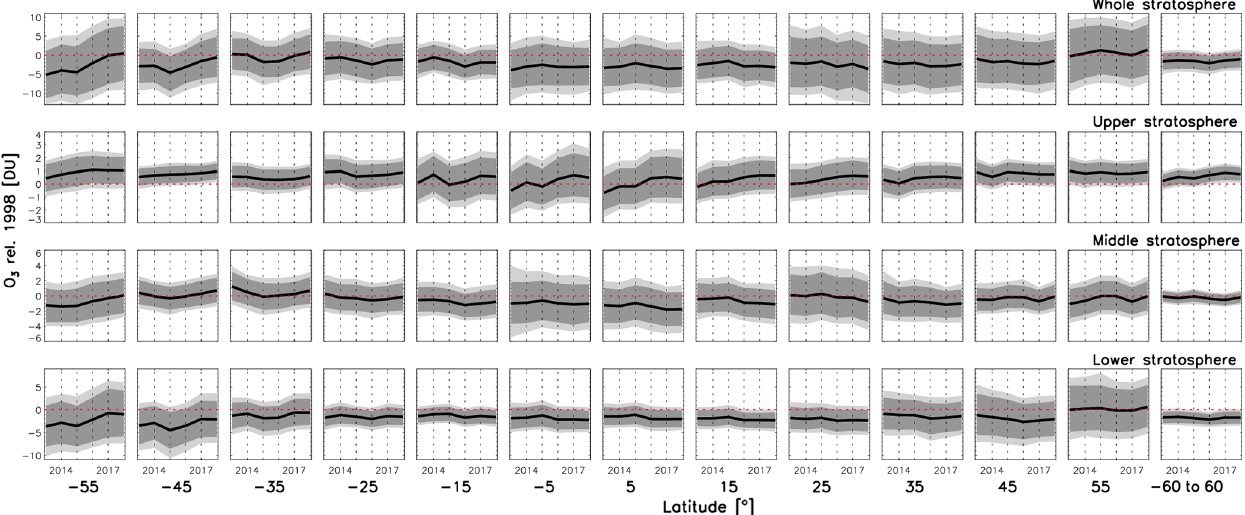
Figure 6. The partial column ozone changes between 1998 and the end year from 2013 to 2018 ( x axis of each sub-panel) from the non-linear trends, as in Fig. 5. Dark and light shading represent the respective 95% and 99% credible